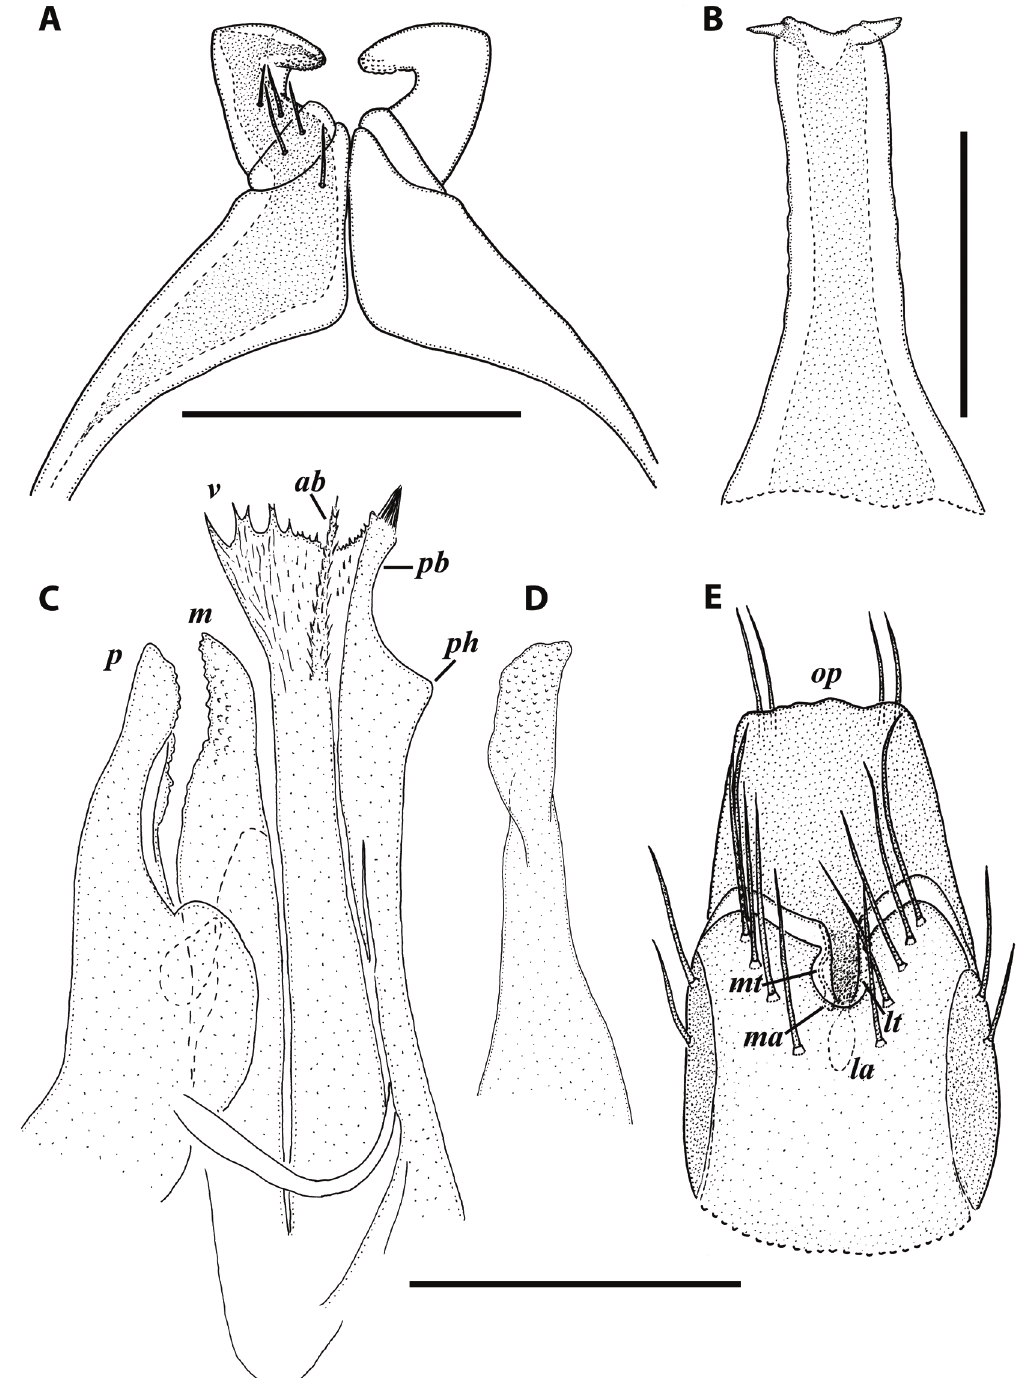
Fig. 9. Stygiiulus rotundatus (Strasser, 1962) comb. et stat. nov., paralectotype ♂ (A) (MHNG), ♂ from Grotta [cave] di Collagù (B) (MHNG) and ♂ (C–D) and ♀ (E) from La Bora Cave (NHMD). A . Leg-pair 1, oral view. B . Penis, oral/caudal view. C . Right gonopods, mesal view (inverted). D . Left mesomere, oral view. E . Left vulva, caudal, somewhat mesal view. Abbreviations: ab = anterior branch of solenomere; la = lateral ampulla; lt = lateral tube; m = mesomere; ma = median ampulla; mt = median tube; op = operculum; p = promere; pb = posterior branch of solenomere; ph = posterior hump; v = velum. Scale bars: A = 0.4 mm; B = 0.2 mm; C–E = 0.3